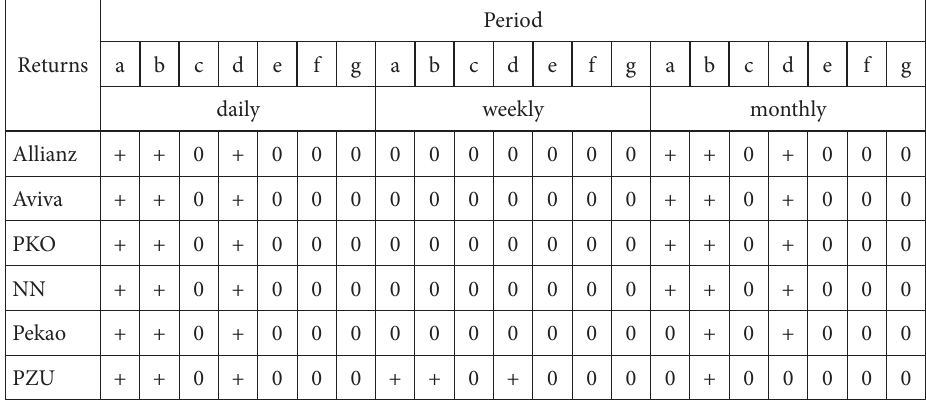
Table 4. Decisions based on statistics (1) for pension funds expected daily, weekly and monthly returns (source: own calculations)